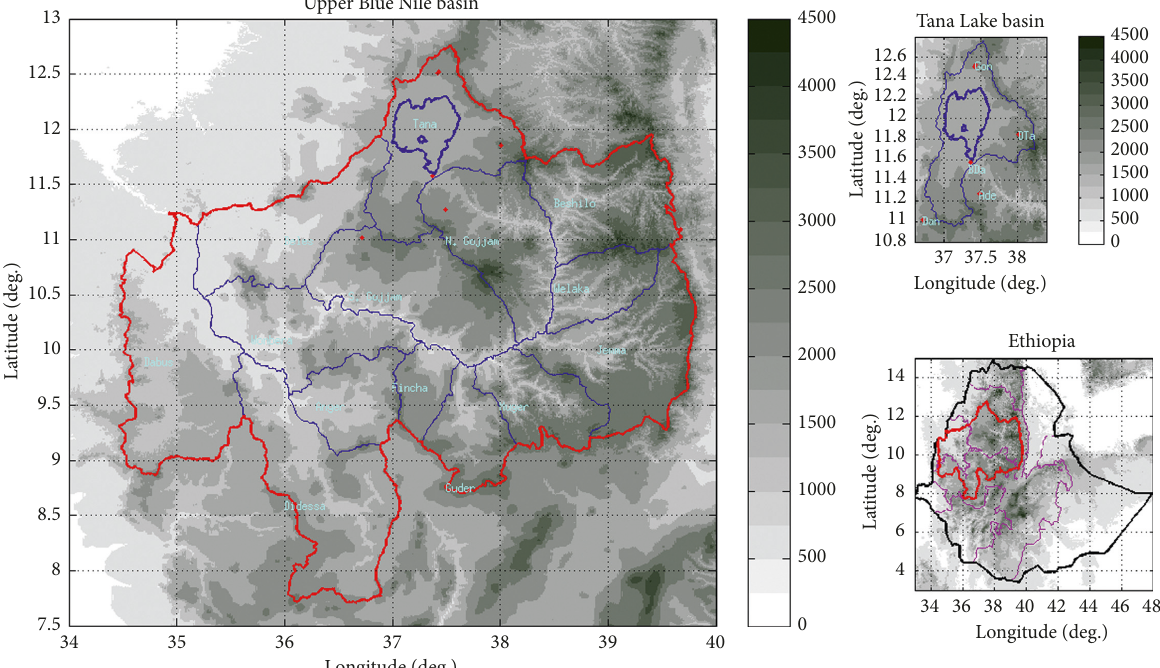
Figure 1: Study area and location of the meteorological stations (red points) used in the